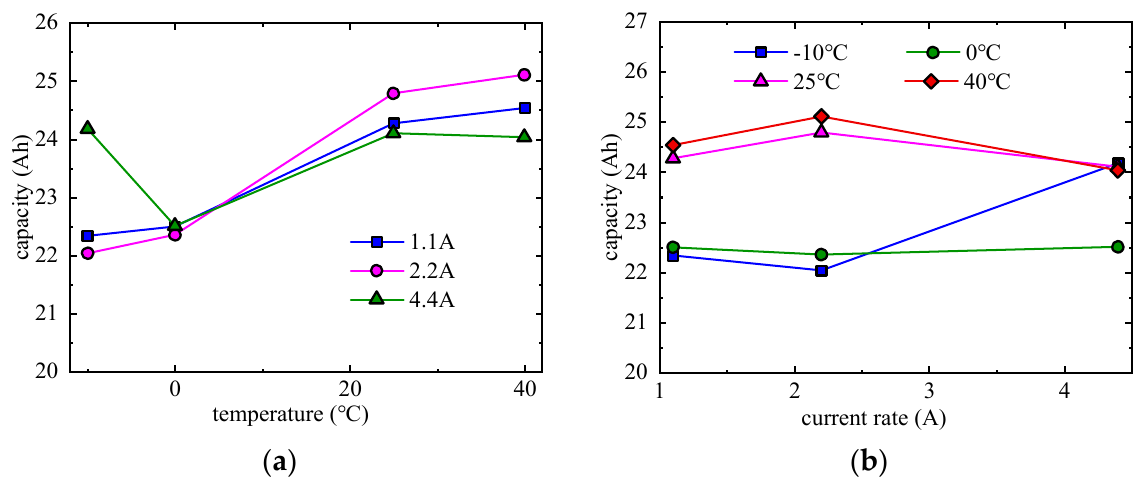
Figure 7. The capacity variation at different temperatures and current rates. ( a ) capacity vs. temperature at different current rates; ( b ) capacity vs. current rate at different temperatures.